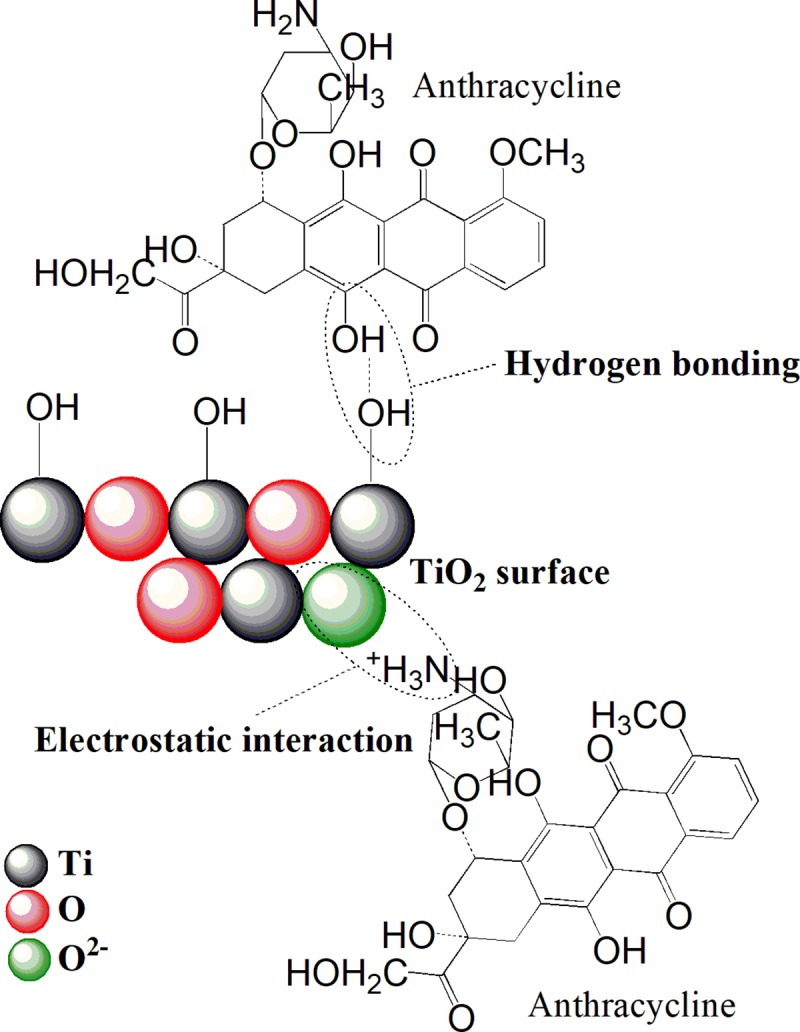
The scheme of the adsorption interaction between anthracycline molecules and TiO2 nanoparticles.